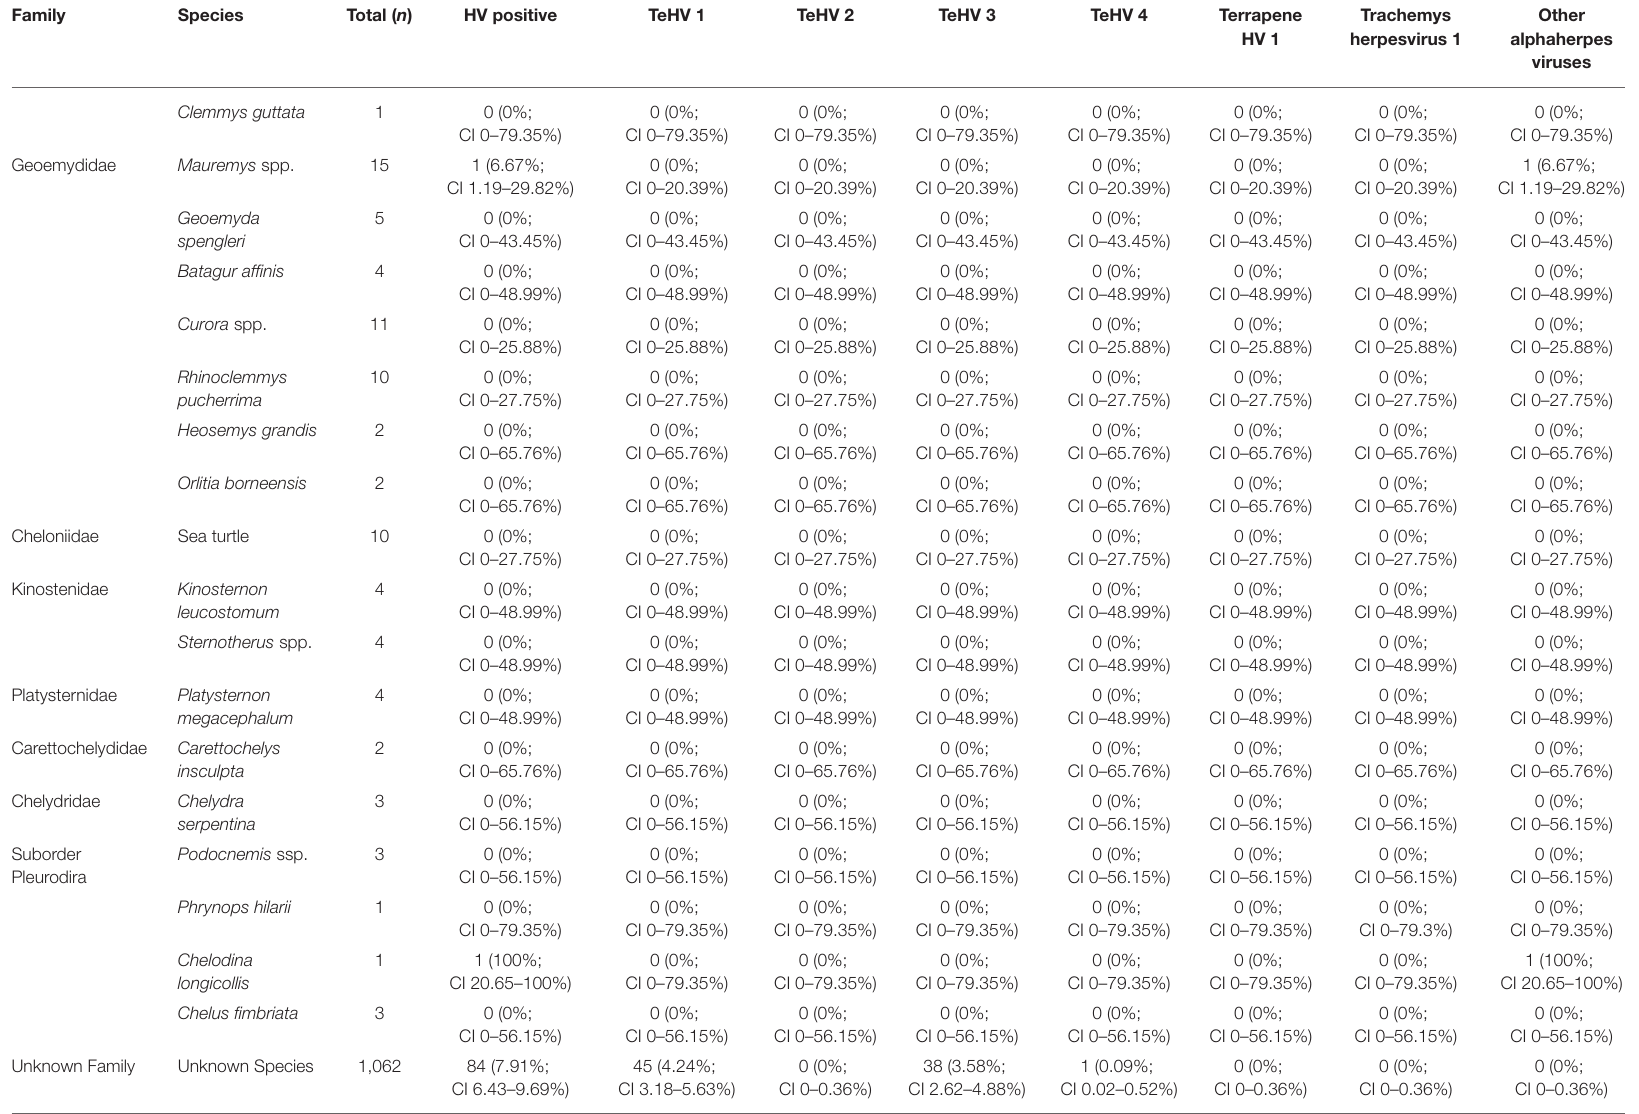
Results shown as: Number positive [% positive of total tested from each individual species; 95% confidence interval